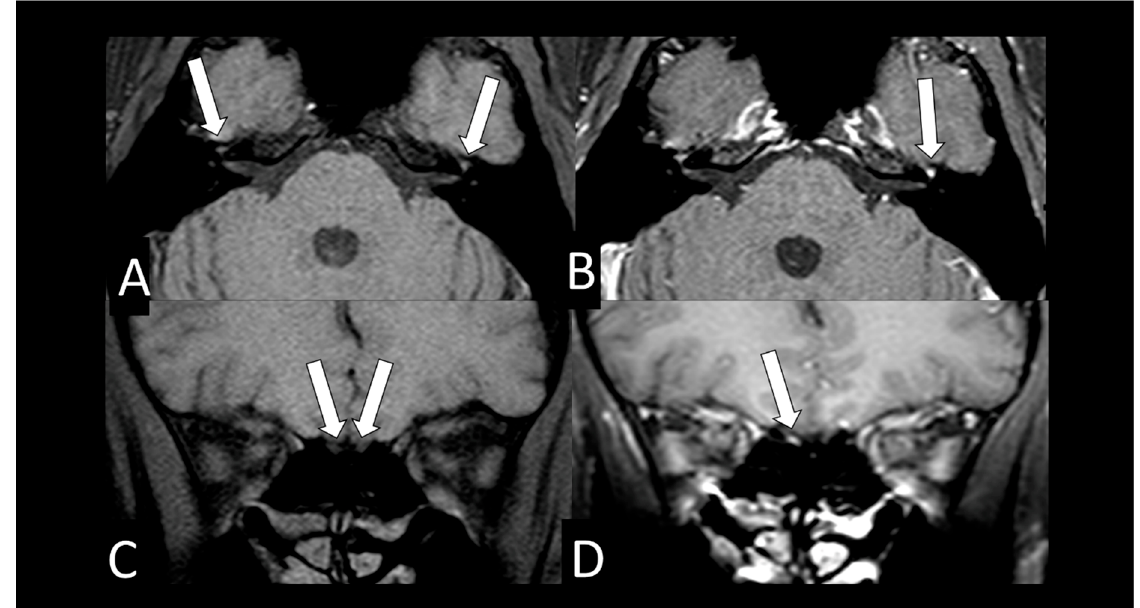
Viruses 2021 , 13 , x 12 of 20 Figure 7. Case 34—The MRI shows a predominantly chronic ischemic stroke, located in the cortical and subcortical region of the right middle cerebral artery territory (M8 and M10) ( A – F , long arrows). In the right M10 territory, the lesion has a small hyperintense “line” on T1 ( A , short arrow) probably methemoglobin; the cortical enhances with contrast ( B , long arrows); is hyperintense on T2 and T2*( C , D , long, arrow), being hyperintense in DWI ( E , long arrows) and hyperintense on ADC-Map ( F , long arrows), representing facilitates diffusion (T2 shine through effect). However, there is still a small area in M10 lesions that shows restricted diffusion of probably more recent ischemic injury being hyperintense in DWI ( E , small arrow) and hypointense in ADC-Map ( F , small arrow). There are small areas of bleeding with magnetic susceptibility in T2 * ( D , arrow head) located in the medial cortical of the right cerebral hemisphere and in the left wall of hypothalamus ( G , arrow) which is reduced in volume on coronal T2WI ( H , arrow). On the angio MRI, parietal irregularity and narrowing in the right M1 is observed ( I , J , arrow) and also in the origin of right anterior artery. Small dot of hyperintensity in the right olfactory bulb ( K , arrow) observed on pre contrast fat suppressed T1WI, which seems have increased signal with contrast ( L , arrow) representing probably methemoglobin and enhancement.